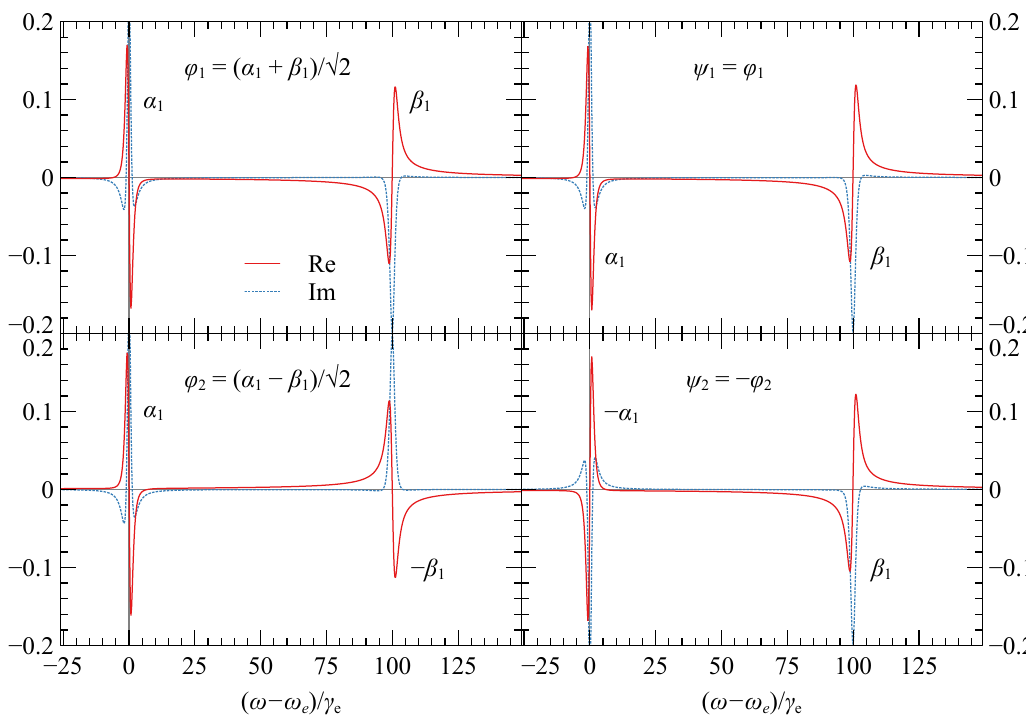
( ω ) , ψ ( ω ) of Schmidt modes computed for a response Figure 3: First two pairs ϕ k k function (15) with ∆ = 100 and δ = − 1.5, discretized on a grid [ − 500;500 ] with a resolution ( 2 + δ ) / 2. These pairs correspond to the Schmidt coefficients r = 0.272348. Because of the large value of ∆ , the Schmidt modes are lin- and r 2 ear combinations of modes α and β centred, respectively, at rescaled frequencies k k ( ω − ω ) /γ 0 and ∆ e e